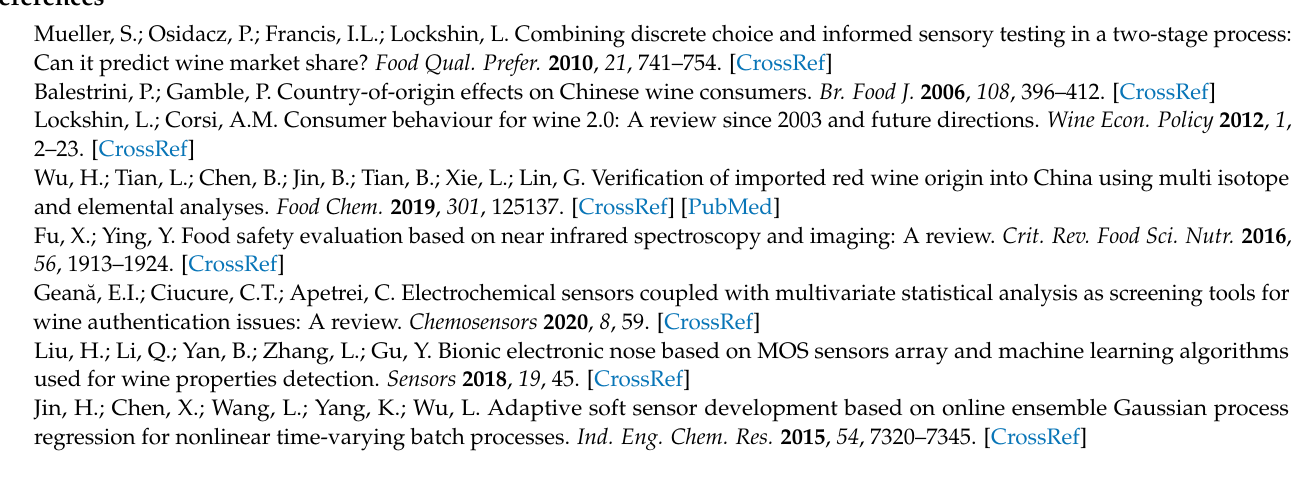
Table S2: 39 samples of New Zealand Pinot noir wines’ product extrinsic cues (No.1–No.117